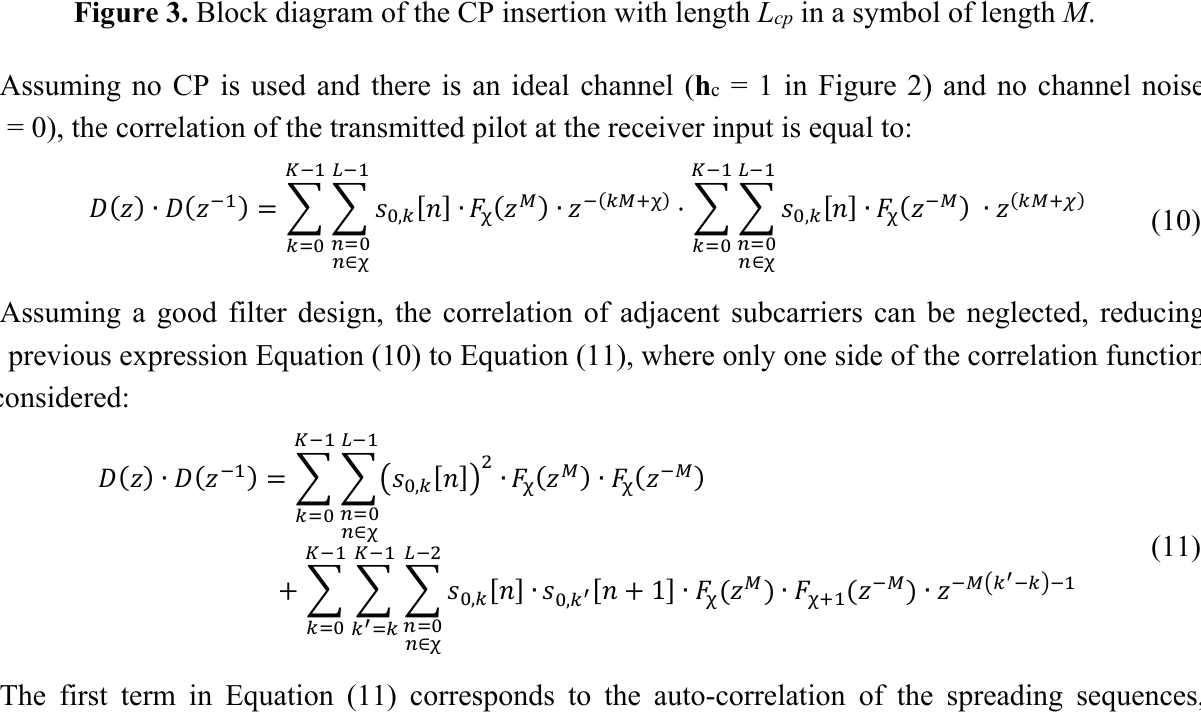
Figure 3. Block diagram of the CP insertion with length L cp in a symbol of length M